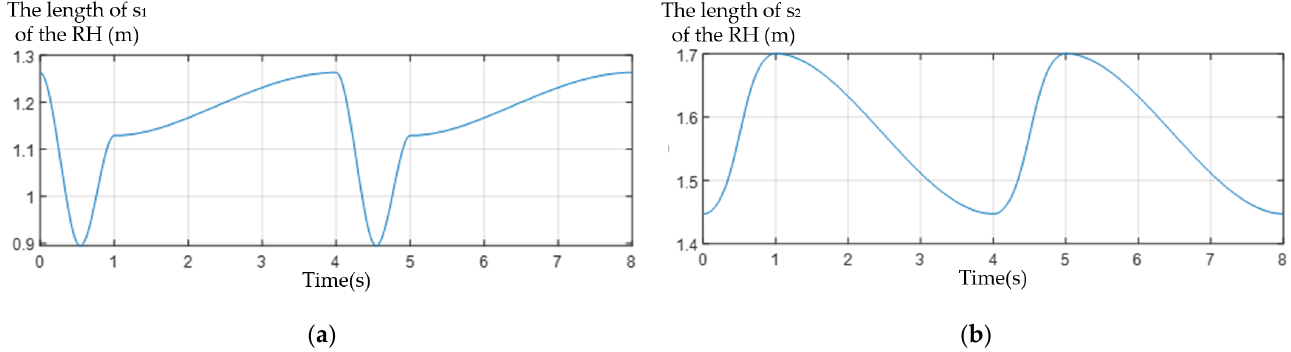
Figure 13. Changes in the length of the supporting leg and swinging leg in two cycles: ( a ) foot coordinates corresponding to s 1 size and ( b ) foot coordinates correspond to s 2 size.